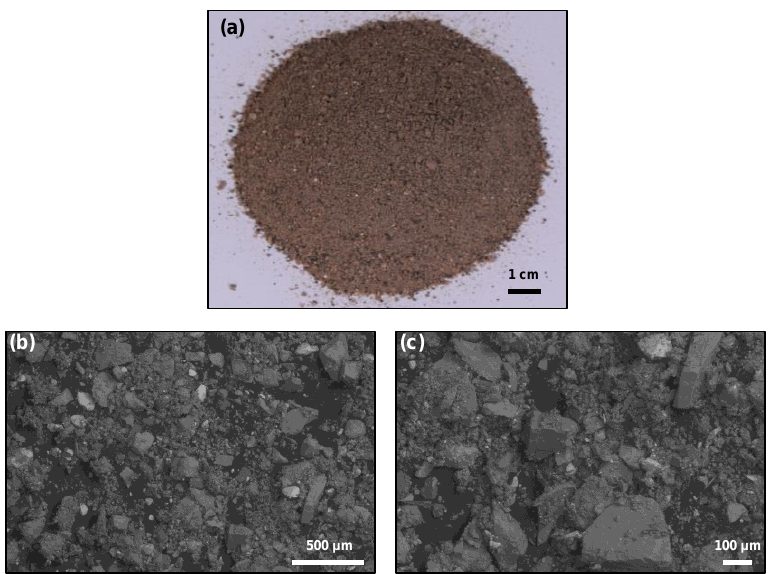
Figure 1. Photograph of Martian regolith simulant JEZ-1: ( a ) typical particles; and representative SEM images of JEZ-1 with magnification of: ( b ) ×50, ( c ) ×100. Table 1. Mineralogy of JEZ-1 (results from Exolith Lab).